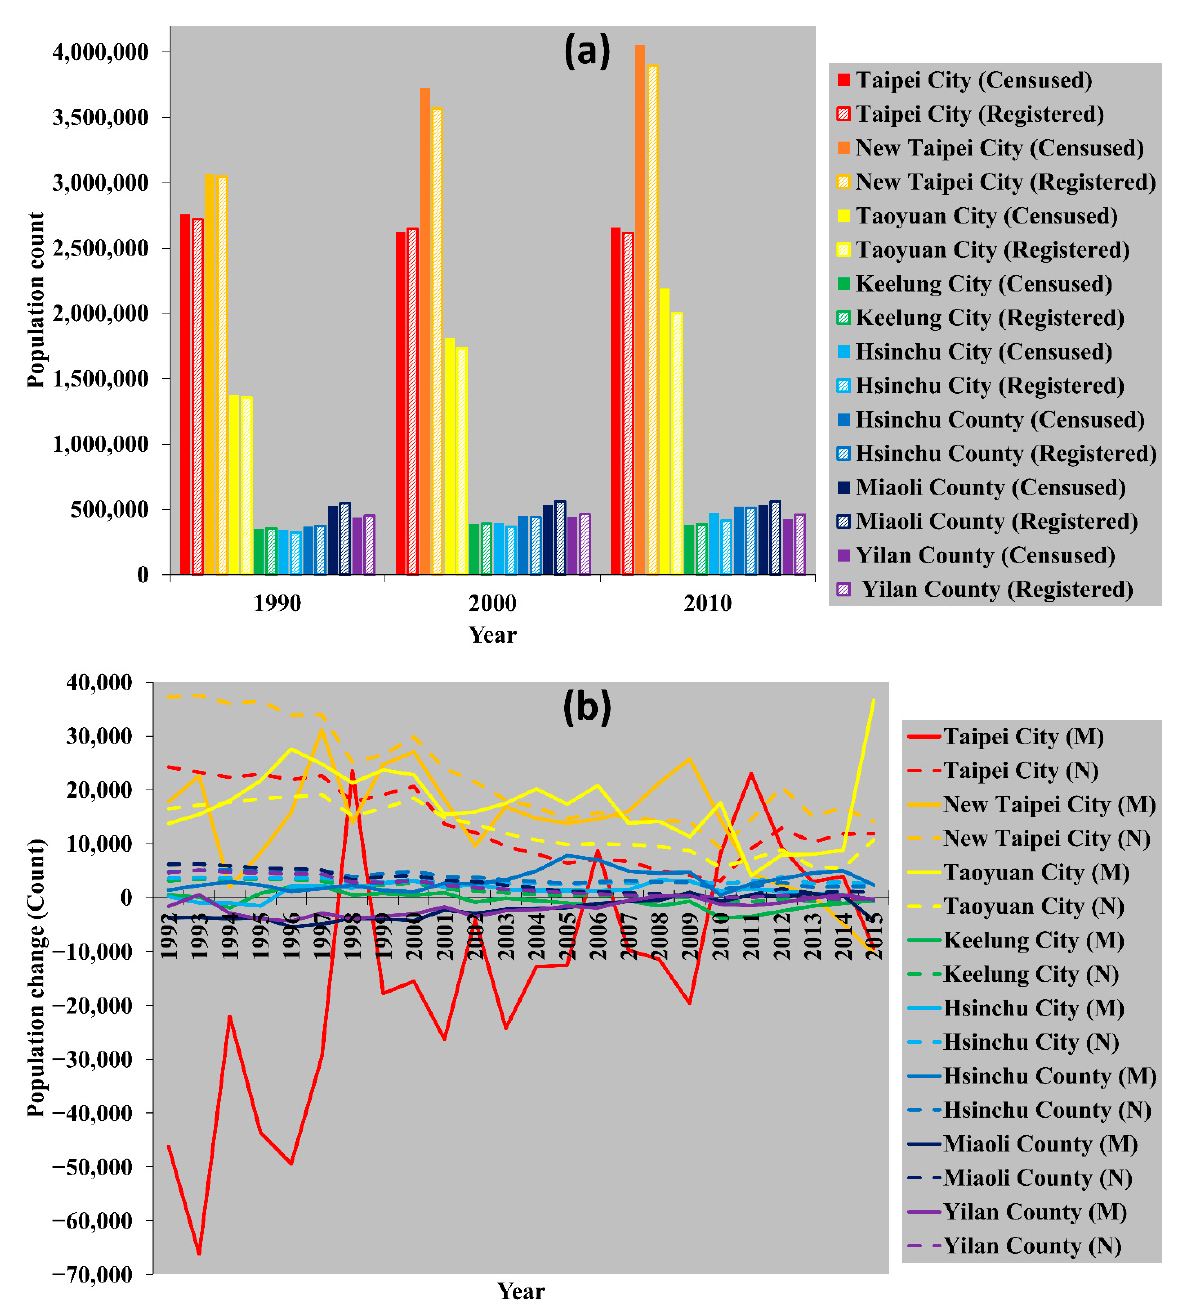
Figure 3. Temporal population dynamics for cities/counties with population data from registers and censuses. ( a ) shows the population count in the three census years. Cities and counties with more in-migrants had more people counted in the census than were registered as living there, while the remainder of counties experienced out-migration. ( b ) shows the annual natural increase (N) and net migration (M) data at the City/County level published by the registered population system.